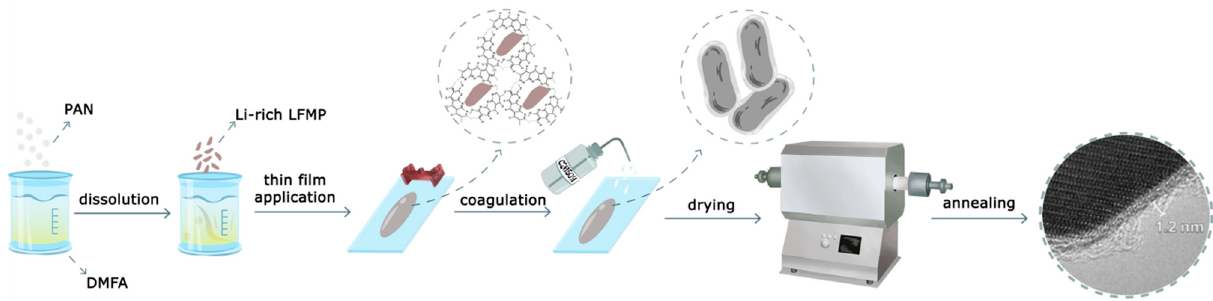
Figure 1. Schematic representation of PAN-nanocoating application technology.